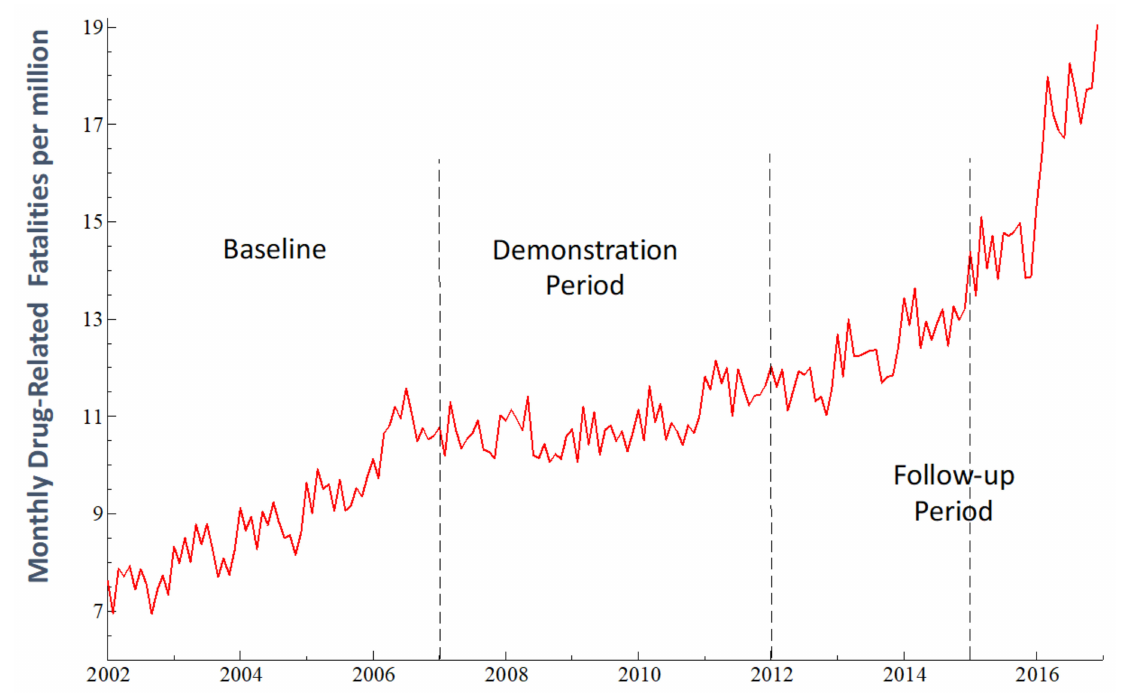
Figure 2. Monthly U.S. drug-related fatality rate per million population